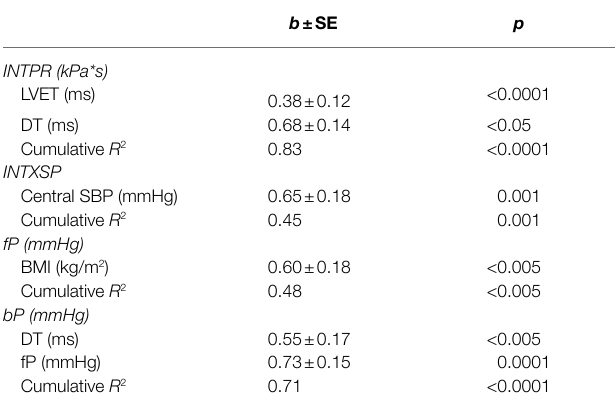
TABLE 3 | Independent determinants of reservoir and excess pressure and separated pressure wave